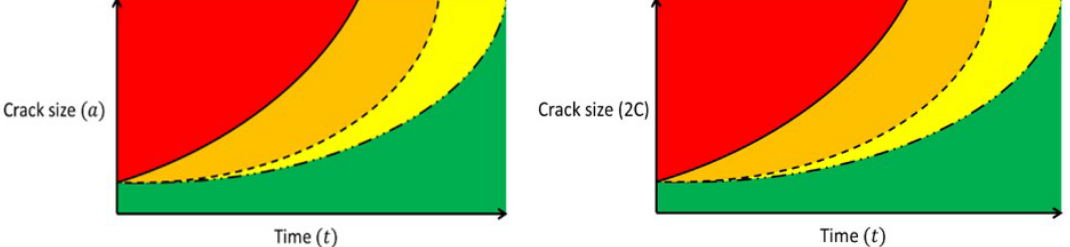
Figure 17. Schematics of crack-growth-curve-based risk